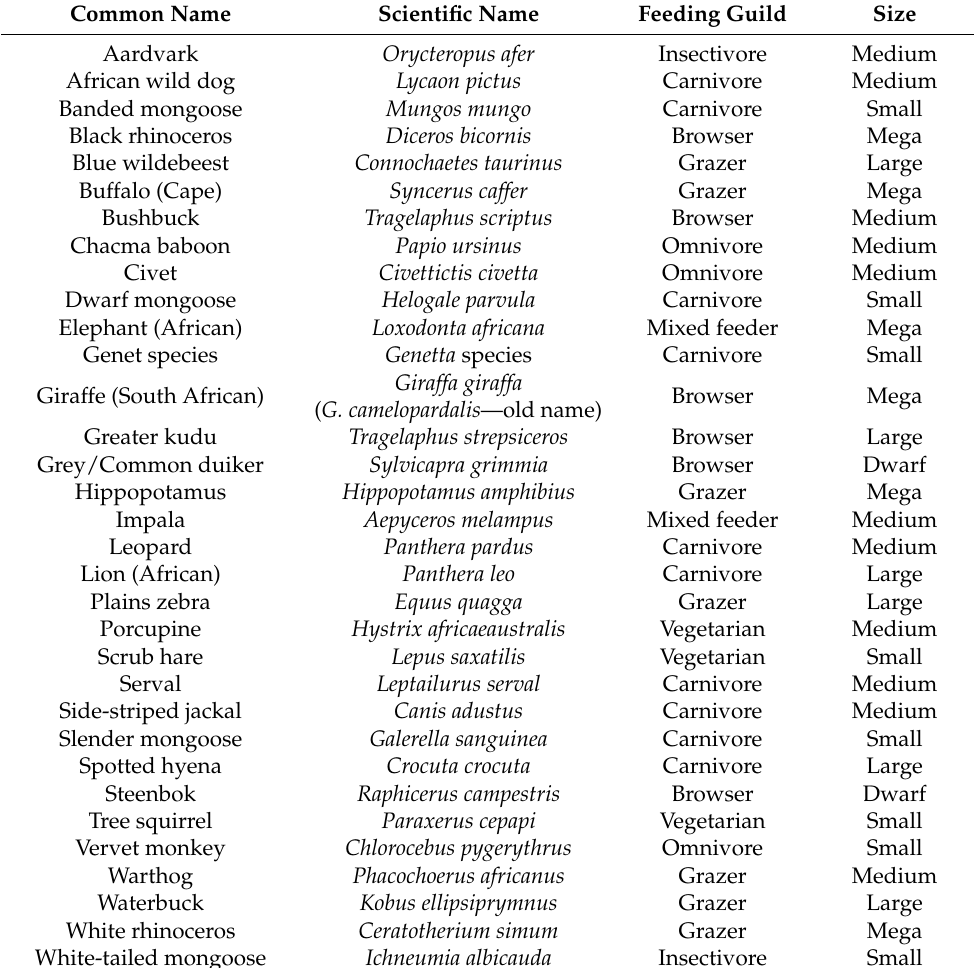
Table 1. Total list of mammal species, including their scientific names, observed on the catena, granite outcrops and nearby waterholes. Their feeding guild and body sizes relative to each other are also